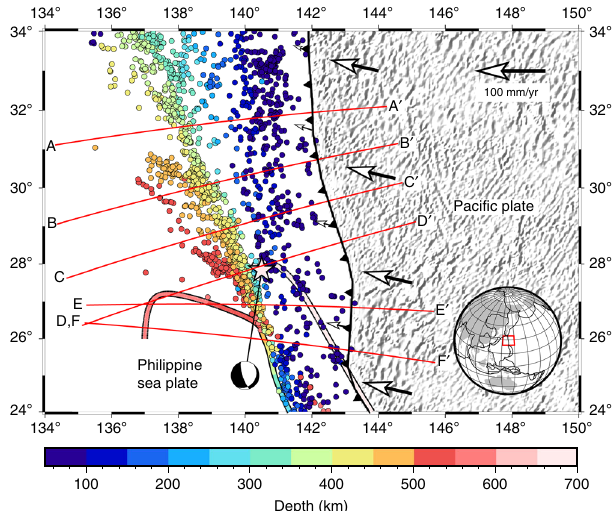
Fig. 1 Overview map of the Izu – Bonin study area. The illumination shows the relief of the Paci fi c Plate (derived from Global Digital Elevation Model ETOPO2) to the east of the trench (Bird 59 ). The convergence velocity between the Paci fi c and Philippine Sea Plates, and the rate of trench advance relative to the no-net reference frame of Argus et al. 60 are shown as white arrows. Relocated earthquakes from the EHB catalogue (1960 – 2008) are coloured according to hypocentral depth. The same colour scheme is used to indicate the depth of the edges of the highest velocity parts of the slab, as estimated from the tomographic inversion. The divergence at around 140.5E, 26.5 N marks the shallow limit of the tomographically observed tear. Lines A – A ’ through F – F ’ correspond to the tomographic sections ( a – f ) plotted in Fig. 2. Note that along Sections D – D ’ and E – E ’ , the deepest parts of the slab extend both towards the west and the east; this is a consequence of the orientation of the slab tear, which is not perpendicular to the trench. The location of the 2015 Bonin Islands deep-focus earthquake is plotted as a